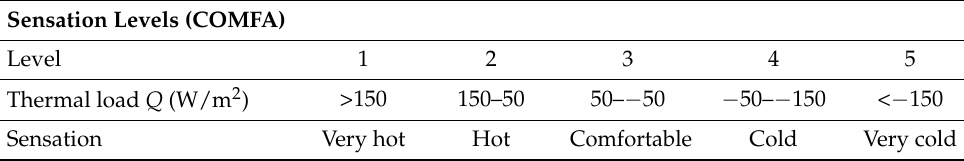
Table 5. Sensation levels according to the thermal load of the COMFA model [54]. Sensation Levels